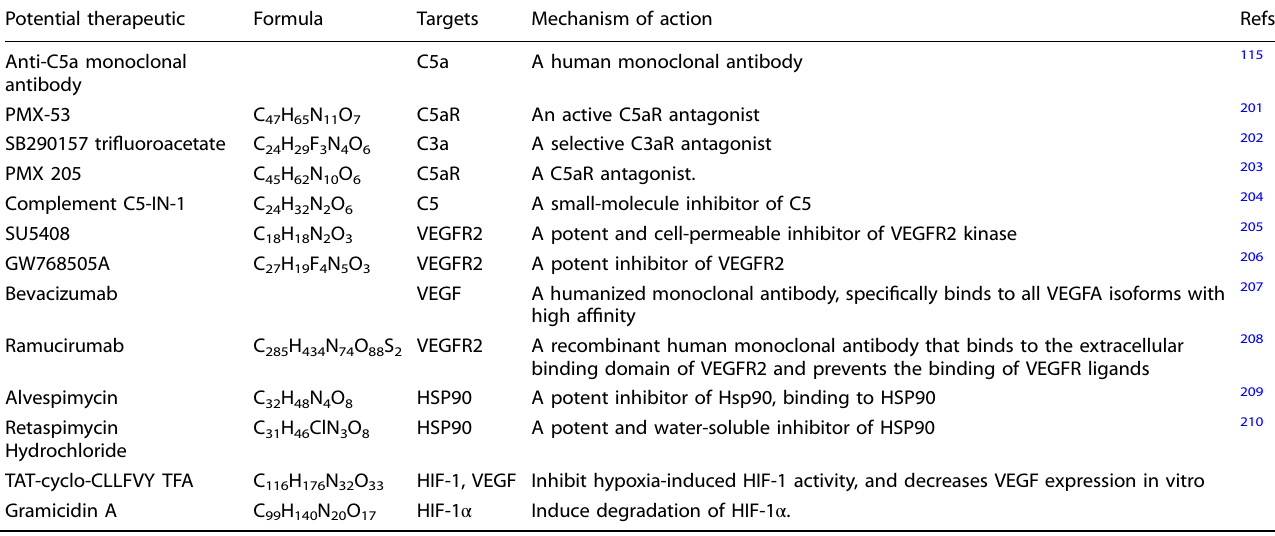
Table 8. Potential therapeutic tools for modulating complement activation, VEGFA/VEGFR2 Pathway, HSP90 and HIF-1